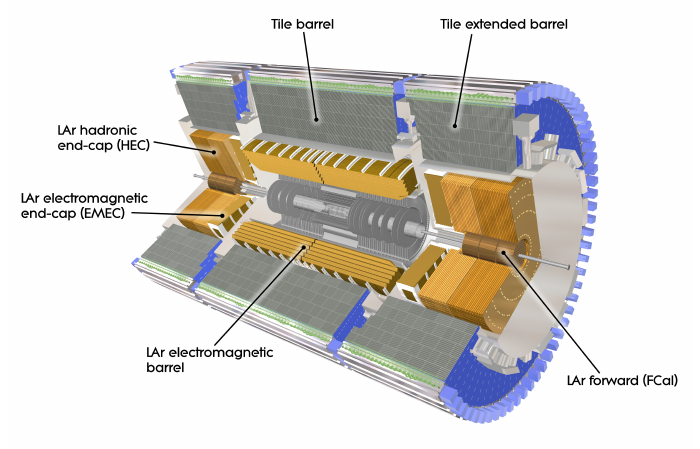
Figure 1. Computer generated image of the ATLAS calorimeter [3]. The LVPS Fingers are illustrated as blue boxes located on the outer radii of the ATLAS inner